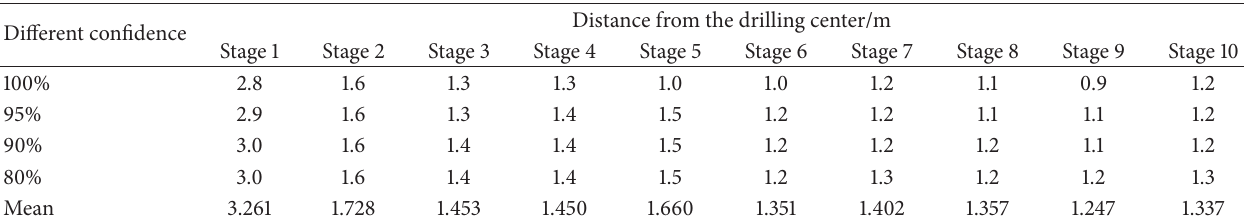
Table 4: Probability of distance in each grouting stage with the permeability rate less than